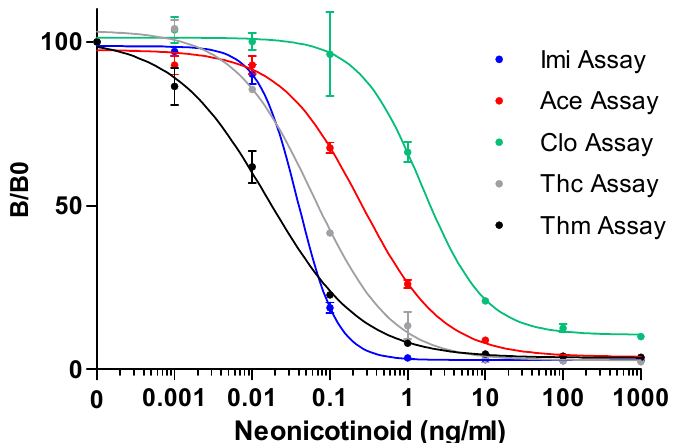
Figure 3. Dose-response curves in PBST-BSA buffer for the five neonicotinoid profiling assays (nMIAs) Figure 3. Dose ‐ response curves in PBST ‐ BSA buffer for the five neonicotinoid profiling assays for detecting their corresponding neonicotinoid targets ( n = 2). (nMIAs) for detecting their corresponding neonicotinoid targets ( n = 2).